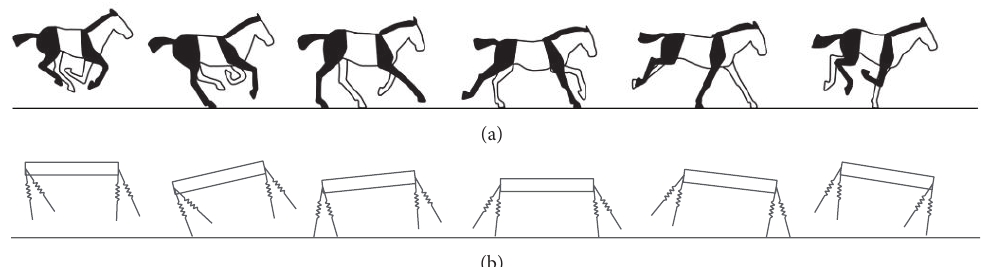
Figure 2: Transverse galloping gait. (a) The equine transverse gallop from the literature [7]. The near side forelimb and hindlimb are indicated in black and the far side is indicated in white. (b) The transverse galloping motion of the model in this paper, which is the same as the real quadrupeds. For we employ the planner dynamic model in this paper, the right and left side of legs are not required for the